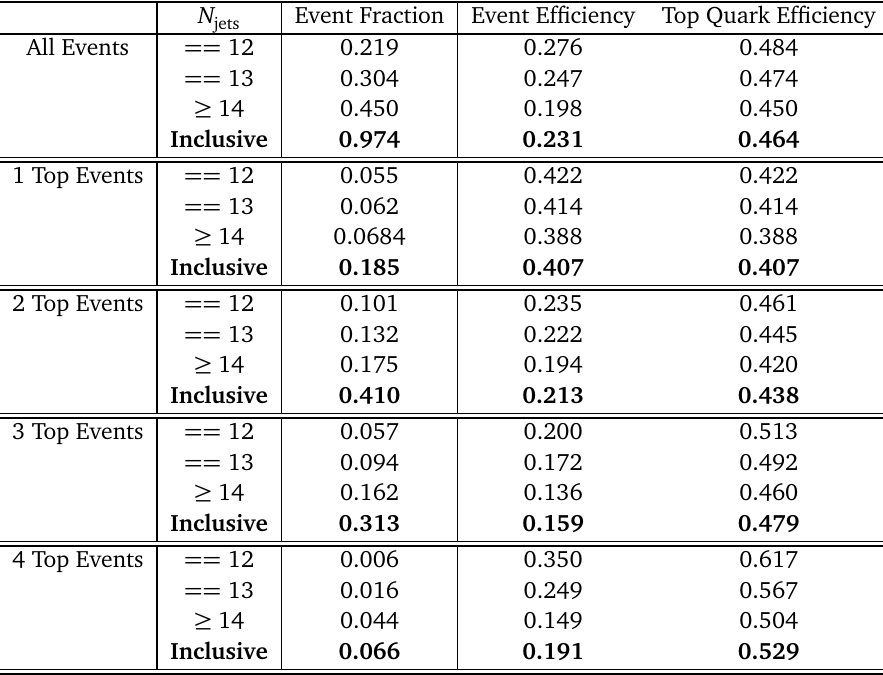
Table 13: S PA -N ET results on t ¯ tt ¯ t with at least 4 b -tagged jets (filtered events). N